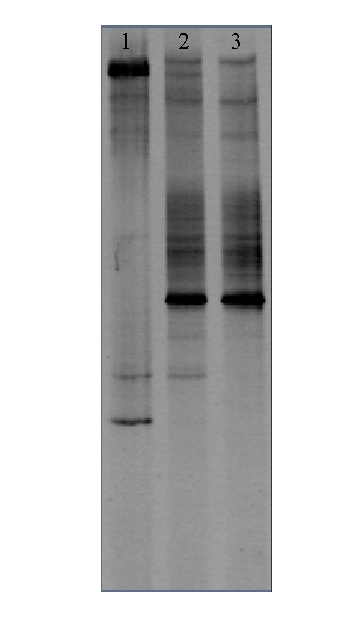
Figure 6. DGGE gel profile of DNA fragments to determine eukaryotic biodiversity in algal microcosms. Lane 1 is for samples collected from the oligotrophic microcosm; Lane 2 is for samples collected from the mesotrophic microcosm; and Lane 2 is for samples that were collected from the eutrophic microcosm.